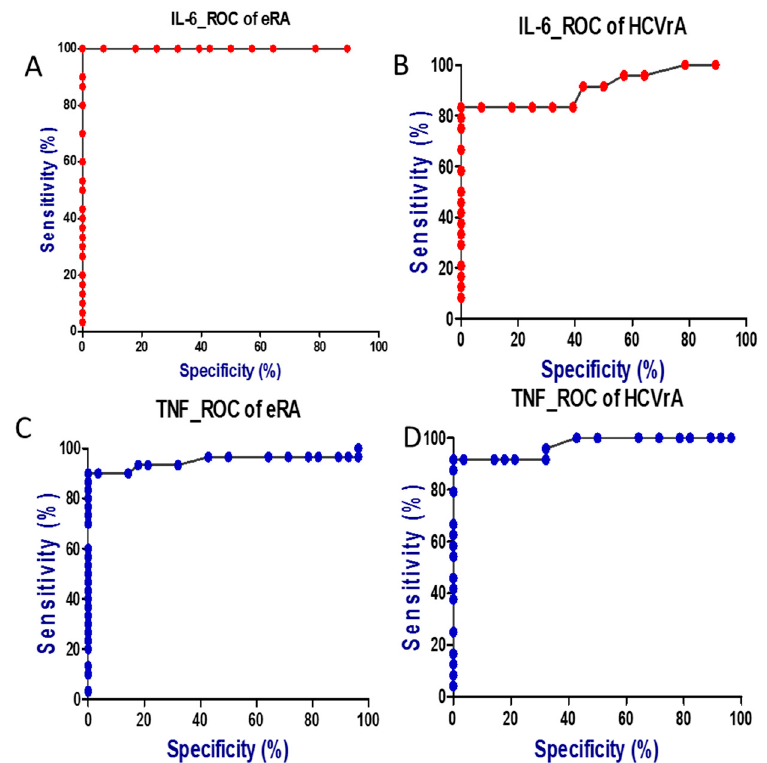
Figure 2. Comparison of receiver operating characteristic (ROC) curves for IL-6 and TNF- α in two subgroups of patients. ( A ) ROC curve for IL-6 in eRA subgroup; ( B ) ROC curve for IL-6 in HCVrA subgroup; ( C ) ROC curve for TNF- α in eRA subgroup; ( D ) ROC curve for TNF- α in HCVrA subgroup.